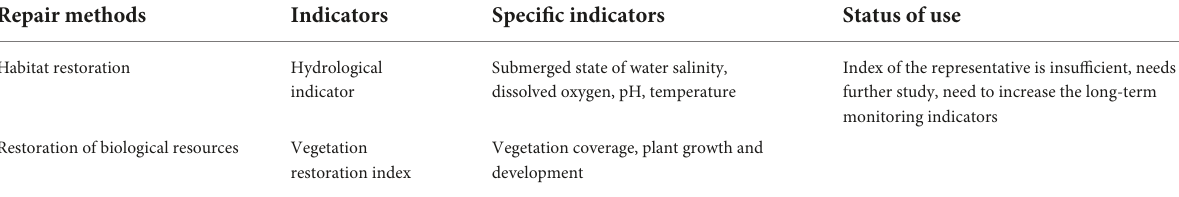
TABLE 3 Evaluation indexes of ecological restoration effectiveness of common salt marsh wetlands.